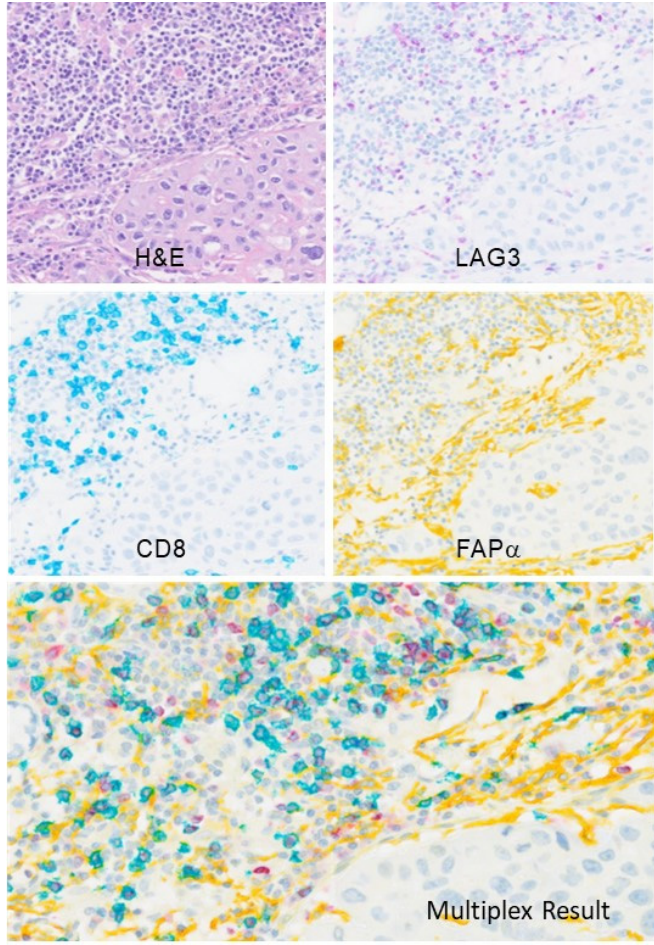
Figure 5. Multiplex IHC of serial NSCLC tissue sections stained using traditional hematoxylin and eosin (H&E), anti-LAG3 clone SP464 (seen in purple), anti-CD8 (SP239) (seen in teal), and anti-fibroblast activation protein, alpha (FAP α , SP325) (seen in yellow). Chromogenic multiplex allows the visualization of all three antibodies on a single tissue section, as shown in the “Multiplex Result” panel.